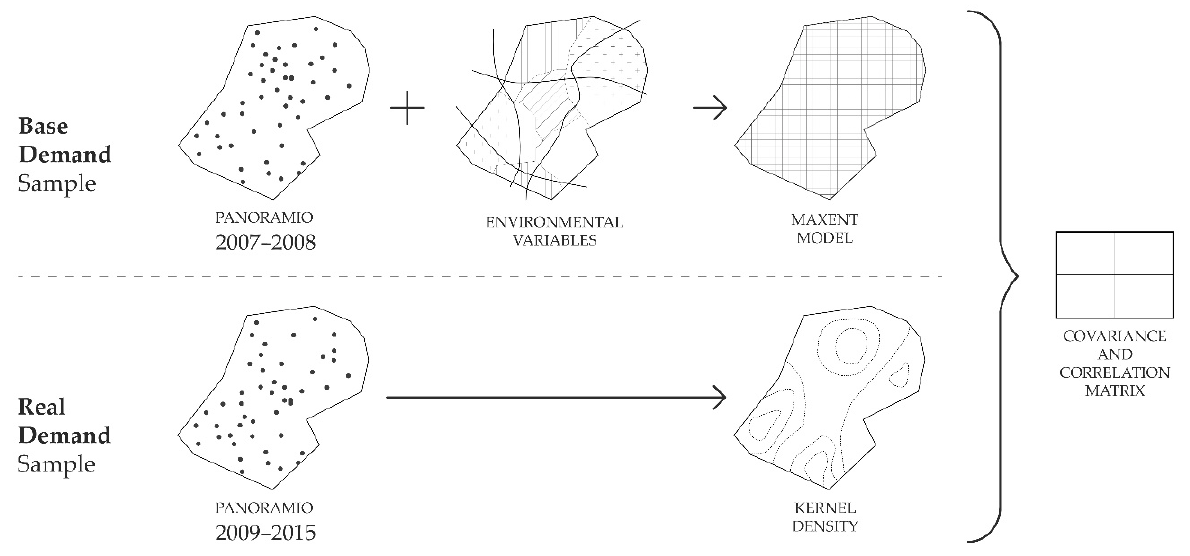
Figure 4. Modeling and correlation diagram.